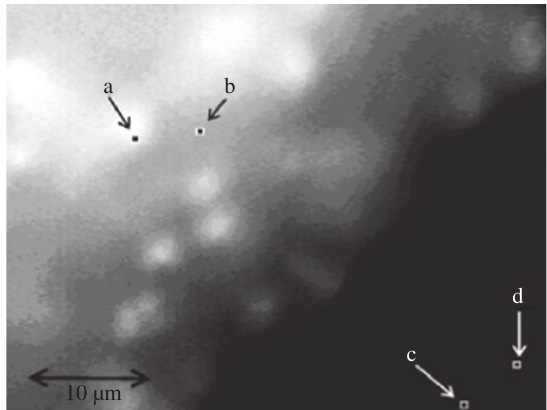
Figure 21 Three-dimensional description of the fl uorescence spectra along the droplet diameter. The Roundup UltraMax droplet was applied on a leaf precoated with a rhodamine 6G layer (Hake et al. 2007).